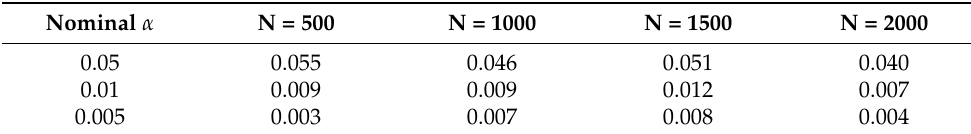
Table 2. Type I error simulation using cGFLM-ZINB for ZINB outcomes based on randomly generated LD blocks.